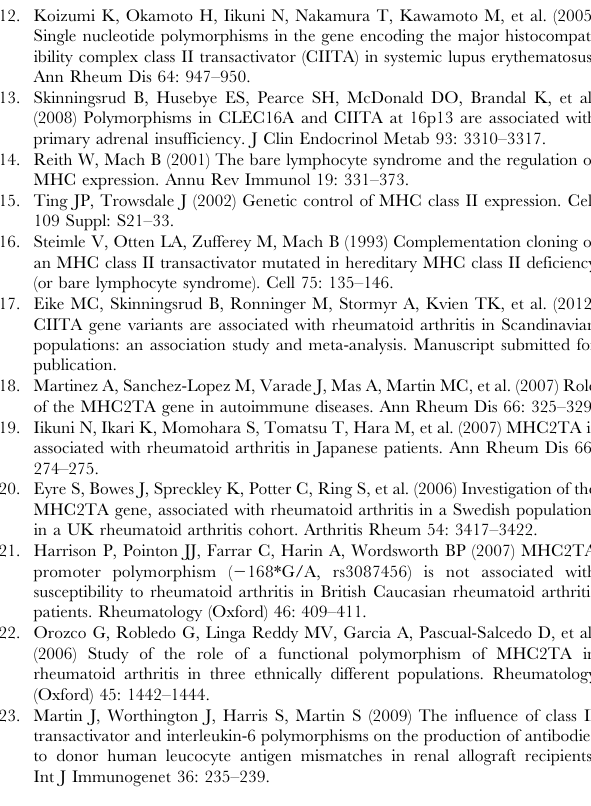
Table S1 Description of the cohorts included in the study. Table S2 Association analyses of the CIITA locus with risk of RA in the Swedish cohort. Pos refers to the genomic position in chromosome 16. MAF is short for minor allele frequency. Plink was used for statistical analysis (http://pngu.mgh.